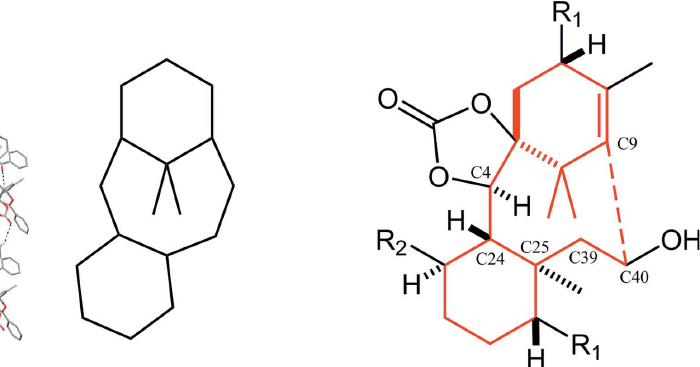
Figure 1 Left: the structure of the tricyclo[9.3.1.0 3,8 ]pentadecane (taxane) skeleton. Right: the title compound. Red lines indicate the taxane skeleton with the expected bond (red dashed line). R 1 = –OC( O)Ph, R 2 = –OCH 2 OCH 3